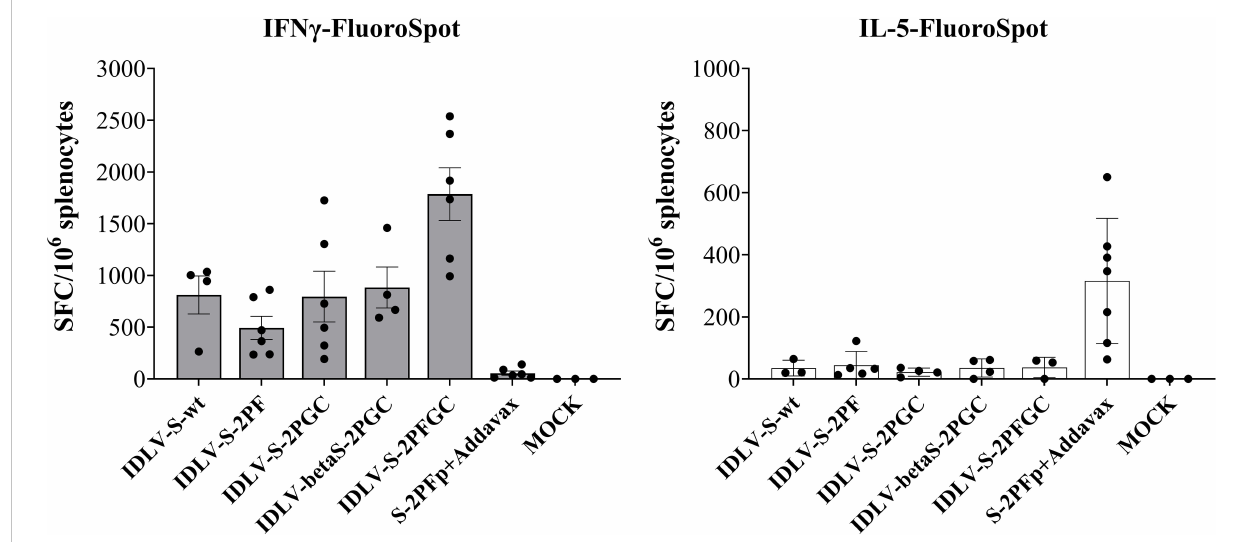
FIGURE 6 T cell immunity persists for six months after a single immunization. Splenocytes from HD groups recovered at 6 months after immunization were assayed for IFN g (left panel) and IL-5 (right panel) producing T cells by IFN g /IL-5-FluoroSpot. Cells were stimulated over night with Wuhan-Spike peptide pool. Data are expressed as mean ( ± SEM) speci fi c Spot Forming Cells (SFC) per million splenocytes. Each dot represents a single